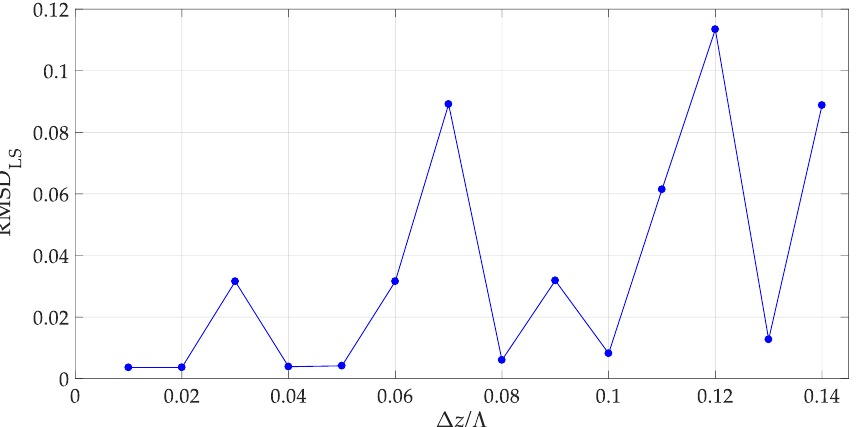
Figure 8. Deviations of the π -phase-shifted FBG spectra from the reference (OptiGrating) spectrum (left axis): deviation of the Layer Sweep method (red line), deviation of the Transfer Matrix method (green line); and reference OptiGrating spectrum (black line, right axis).